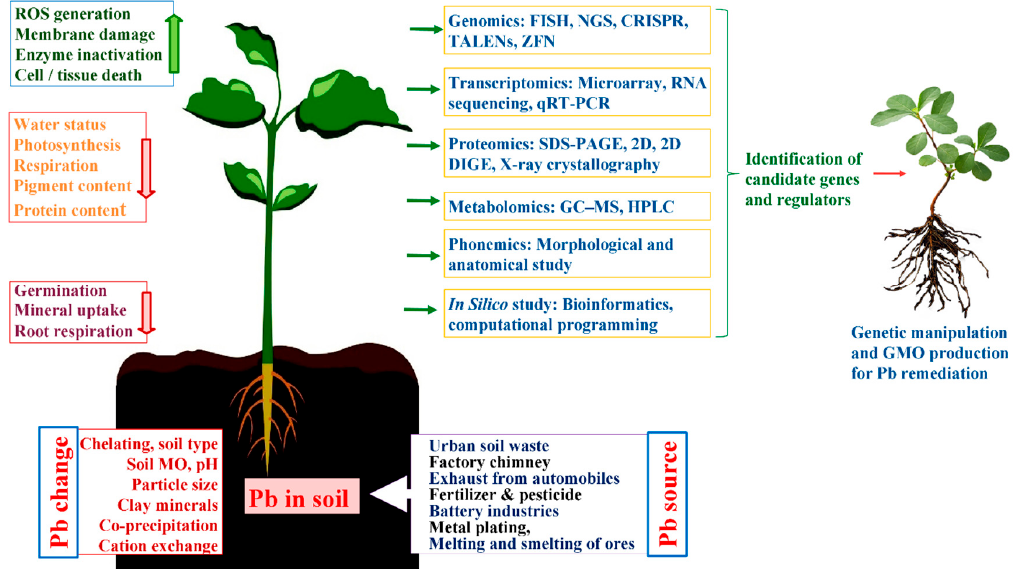
Figure 1. Biotechnological and Genetic Approaches for the development of efficient remediation systems. Table 9. Characteristics of nano-particles in Pb removal